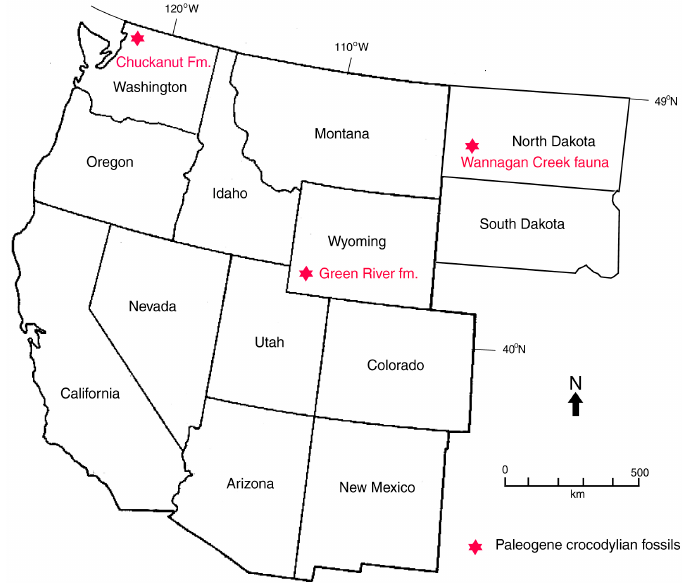
Figure 18. Location of Paleogene Crocodylian fossil localities in Western USA.